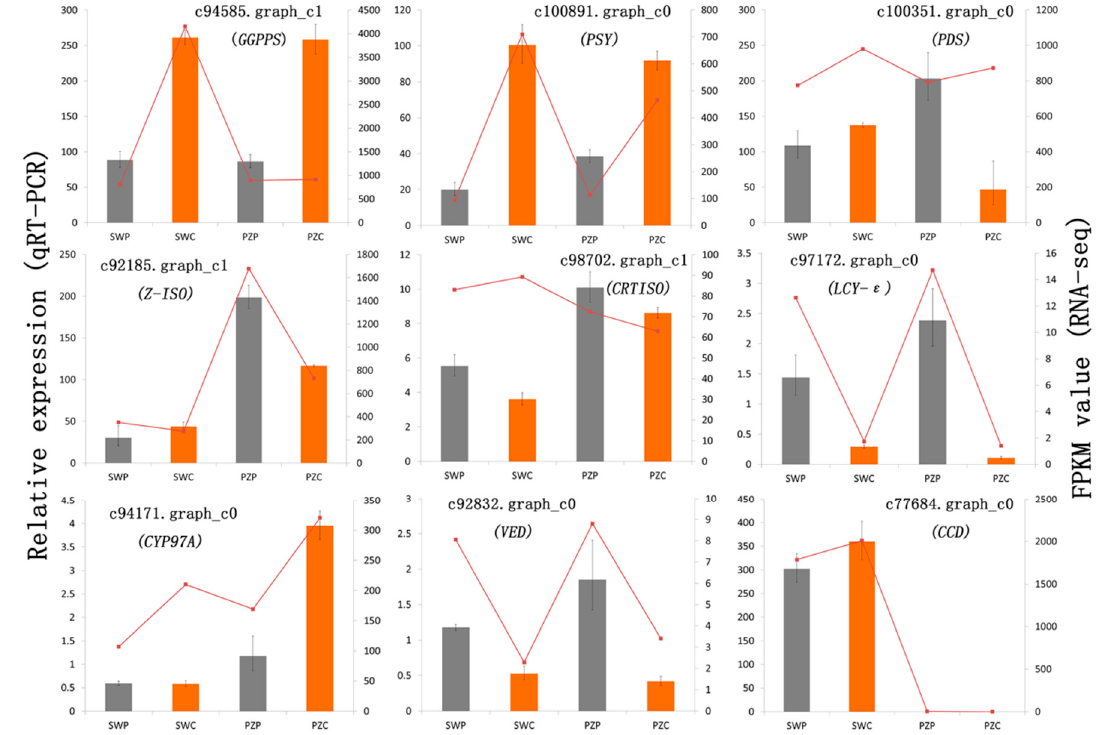
Figure 5. Comparison of expression profiles of nine representative genes from SWP, SWC, PZP, and PZC as measured by RNA-seq and quantitative real-time PCR (qRT-PCR). The nine genes are assigned to the of carotenoid biosynthesis pathway in Figure 4. Columns represent expression determined by qRT-PCR (left y-axis), while lines represent expression by RNA-seq in FPKM values (right y-axis). The x-axis in each chart represents the SWP, SWC, PZP and PZC, respectively. For qRT-PCR assay, the mean was calculated from three biological replicates each with three technical replicates ( n = 9). For RNA-seq, each point is the mean of two biological replicates. Correlations between qRT-PCR and RNA-seq expressions were calculated and their associated p -values are 7.53 × 10 − 10 . R 2 = 0.823.